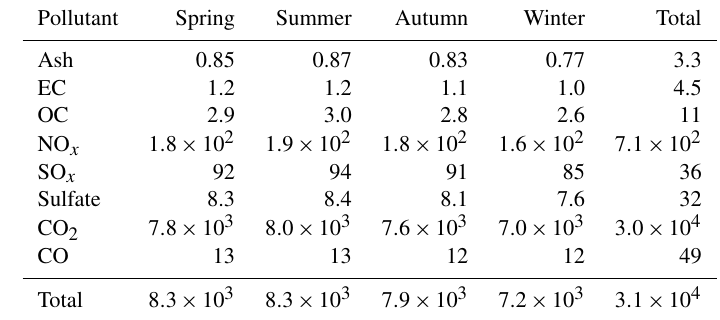
Table 4. Seasonal amounts of emitted air pollutants from shipping in the Iberian Peninsula in 2015 (tyr − 1 ) . Pollutant